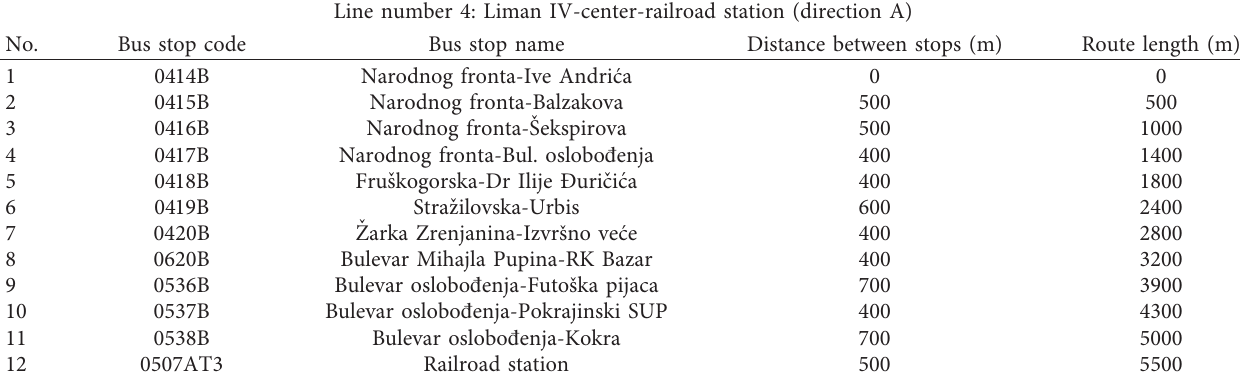
Table 1: Characteristics of the stops of line 4, direction A.